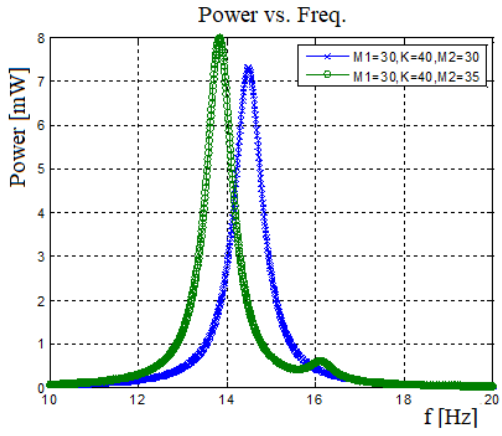
Figure A4. Harvested power—two bimorphs interconnected by a spring case ‐ end mass influence: M 2 = 30 gr & M 2 = 35 gr. Table A3. Two bimorphs interconnected by a spring system—the influence of the value of M 2 on the harvested power ( M 1 is constant 1 = 30 gr).